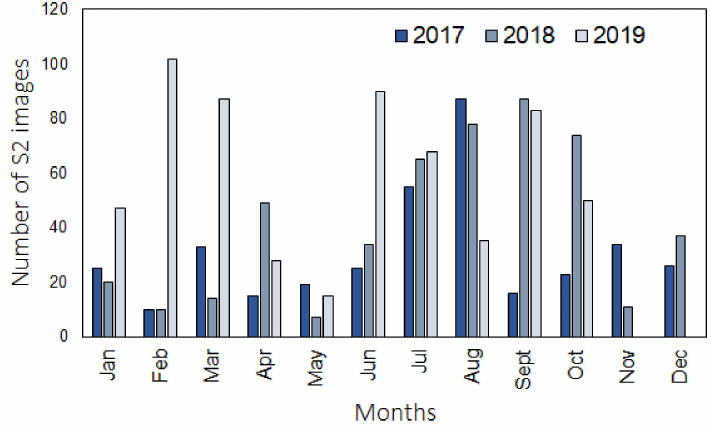
Figure 2. Number of S2 images per month and years of the image